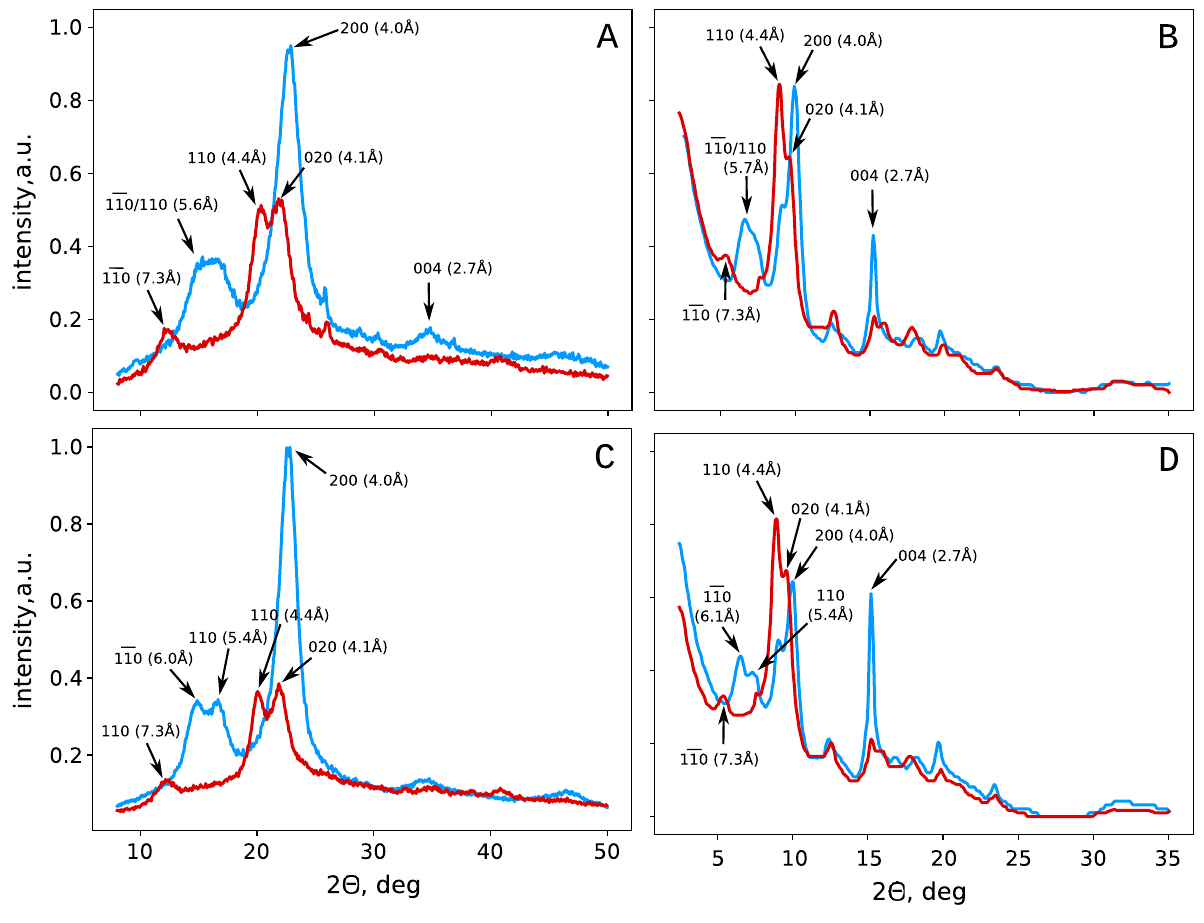
Figure 2. Typical diffractograms of the initial (blue curves) and mercerized (red curves) hardwood ( A , B ) and flax ( C , D ) cellulose obtained using the plain X-ray of 1.54 Å in reflection mode ( A , C ), or synchrotron X-ray radiation of 0.69Å ( B , D ) in transmission mode. The arrows denote the prominent peaks attributed according to French (2014) 46 .